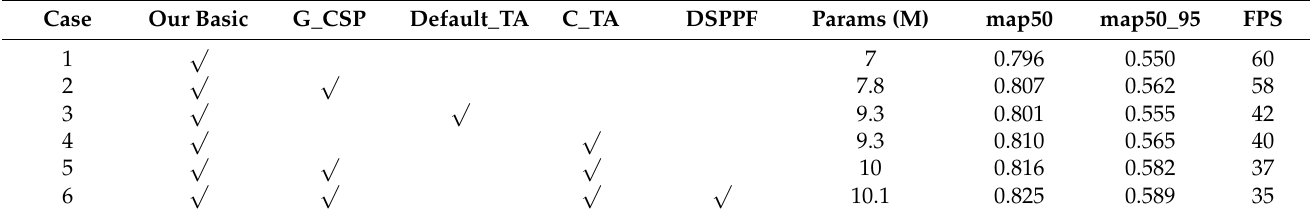
Table 4. Ablation studies on bag-of-freebies using different components (YOLOv5s, 640 ×